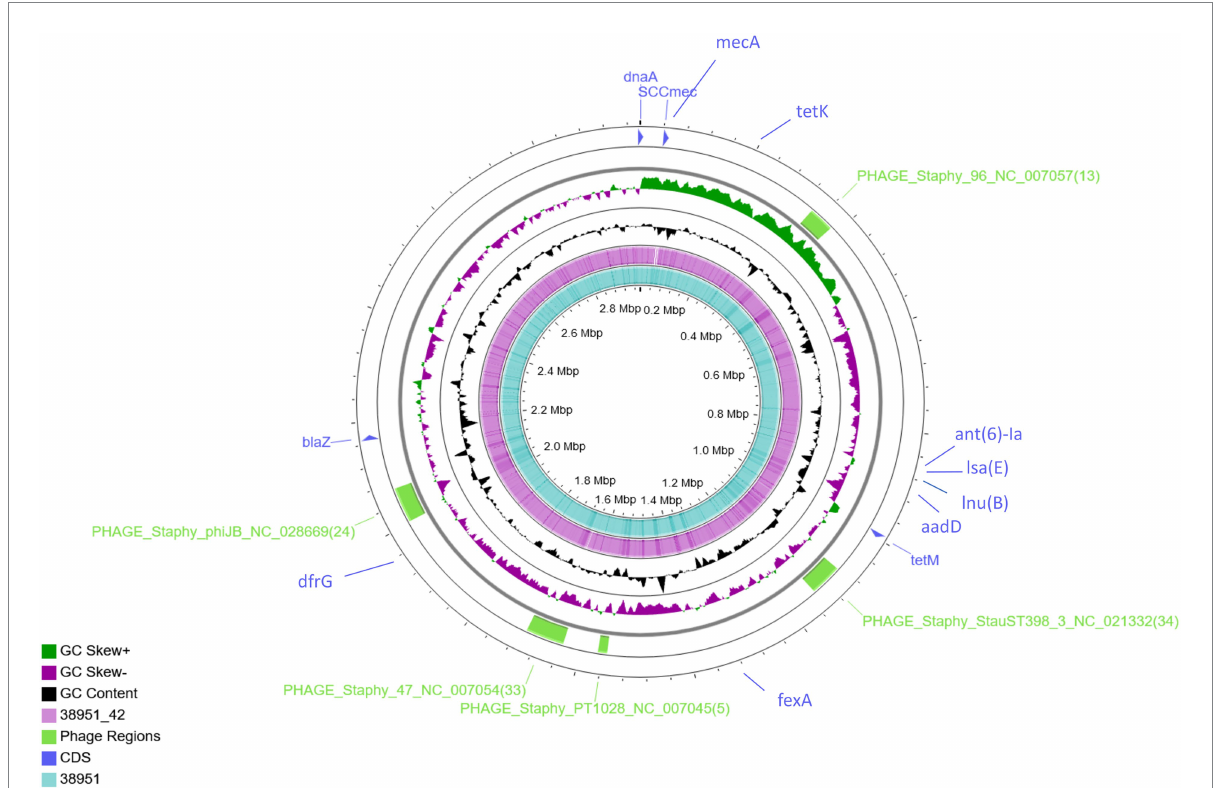
FIGURE 1 Genome-wide comparison of MRSA ST398 (IMT38951) and its descendant MSSA (IMT38951_42). A combinatorial approach including long reads (PacBio) and short reads (Illumina sequencing) allowed precise reconstruction of both genomes. Five regions harbouring phages or phage- associated genes identified using PHASTER are indicated in green. Location of resistance genes identified using ResFinder 2.1 and the SCC mec intergration site are indicated in blue. Comparative genomics determined a difference of 10 single nucleotide polymorphisms in total (excluding phage regions).